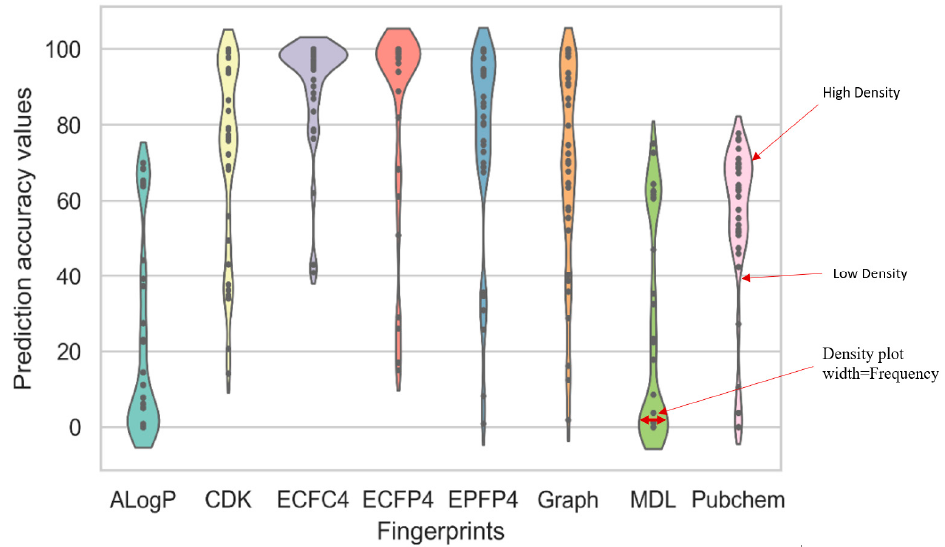
Figure 4. Prediction accuracy values of the CNN model for the eight fingerprint representatives using the violin-plot charts.